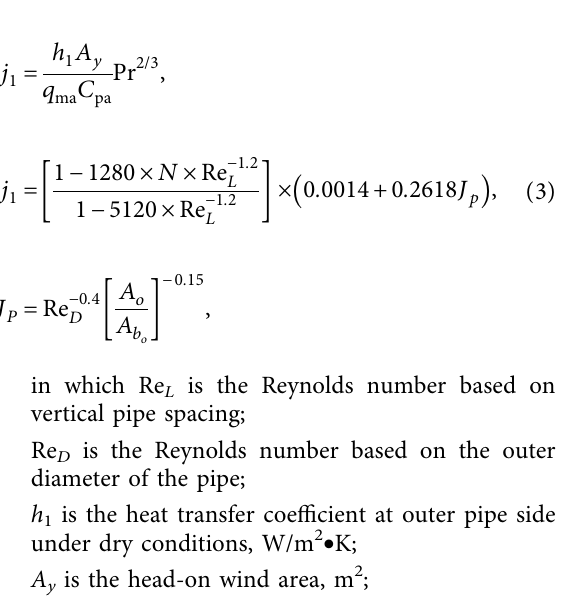
Figure 1: Structure diagrams of surface air cooler (a,